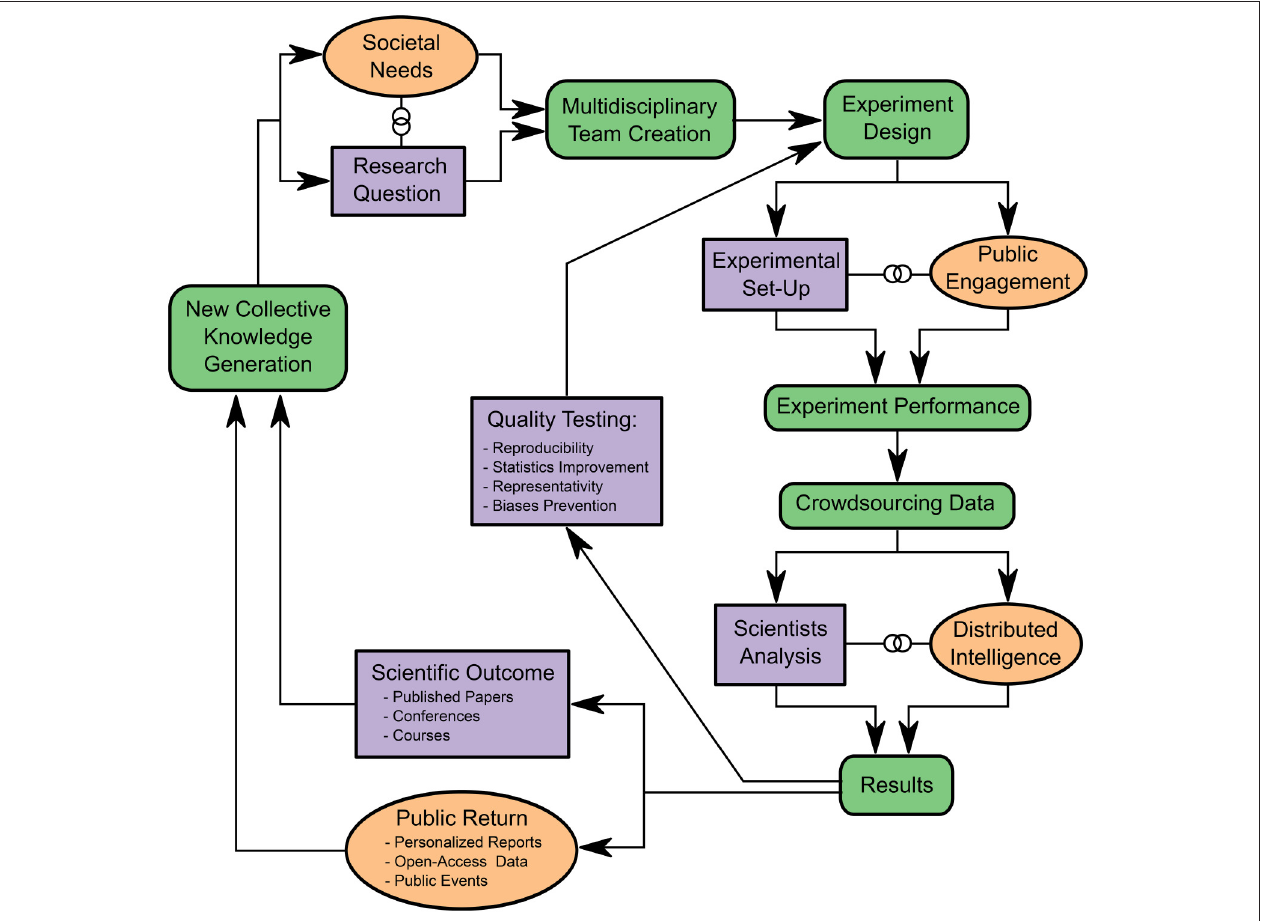
FIGURE 1 | The research process in pop-up experiments. We identify the different steps in the whole process in a set of boxes, from conception to completion. Starting from the research question, we introduce the design and performance of a given experiment that is intended to respond to a particular challenge. The crowdsourced data gathered can be analyzed both by expert scientists and amateur citizens to produce new knowledge (the return) in different forms. The results are finally taken as inspiration and renewed energy to face new challenges and new research questions. Data quality is also part of the process: the lessons learned from the scientific analysis can improve future experimental conditions. Ovals in orange: volunteers’ contributions; squares in magenta: tasks performed exclusively by scientists; rounded rectangles in green: tasks shared by both citizens and